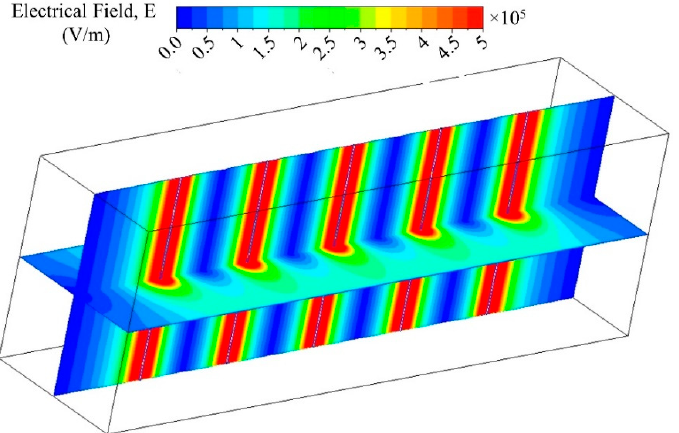
Figure 9. Distribution of electric field (E) magnitude at the midplanes in the case of d w = 1 mm, 45 kV, and U in = 2 m/s in the 230 mm wide channel.